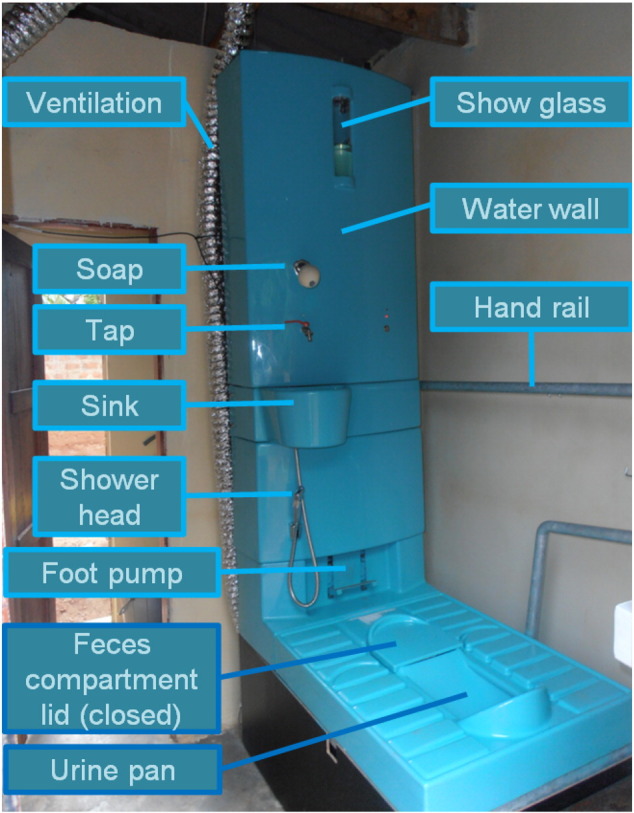
The working model of the Blue Diversion Toilet as used in the Kampala field test. The water wall contains the water tanks and bio-reactor. The metallic tube (labeled ventilation) is part of the active ventilation of the feces compartment to prevent odor.